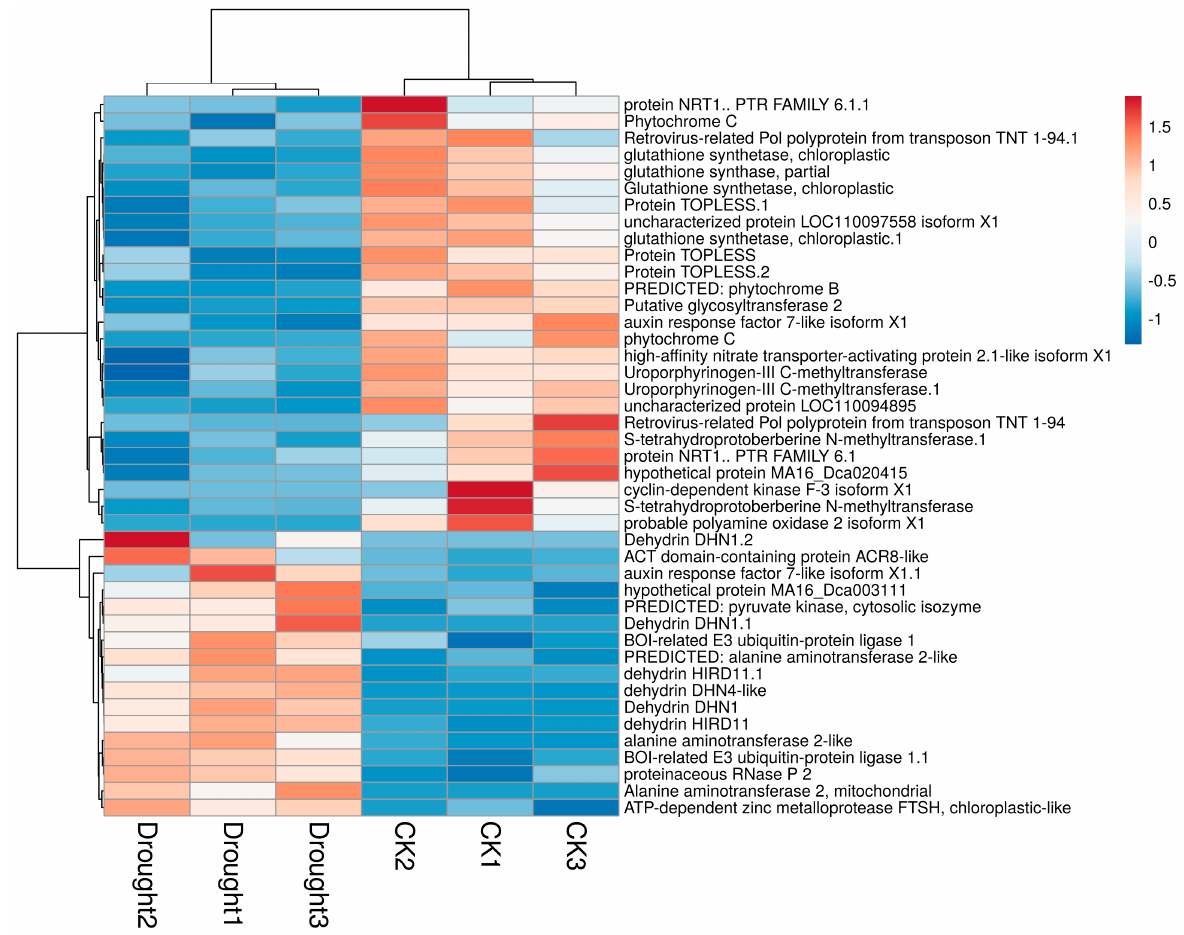
Figure 7. The expression profiles of DEGs involved in four GO terms in B. striata under CK and drought conditions, including response to water (GO:0009415), response to an abiotic stimulus (GO:0009628), response to an inorganic substance (GO:0010035), and response to an oxygen-containing compound (GO:1901700). Each group has three replicates.